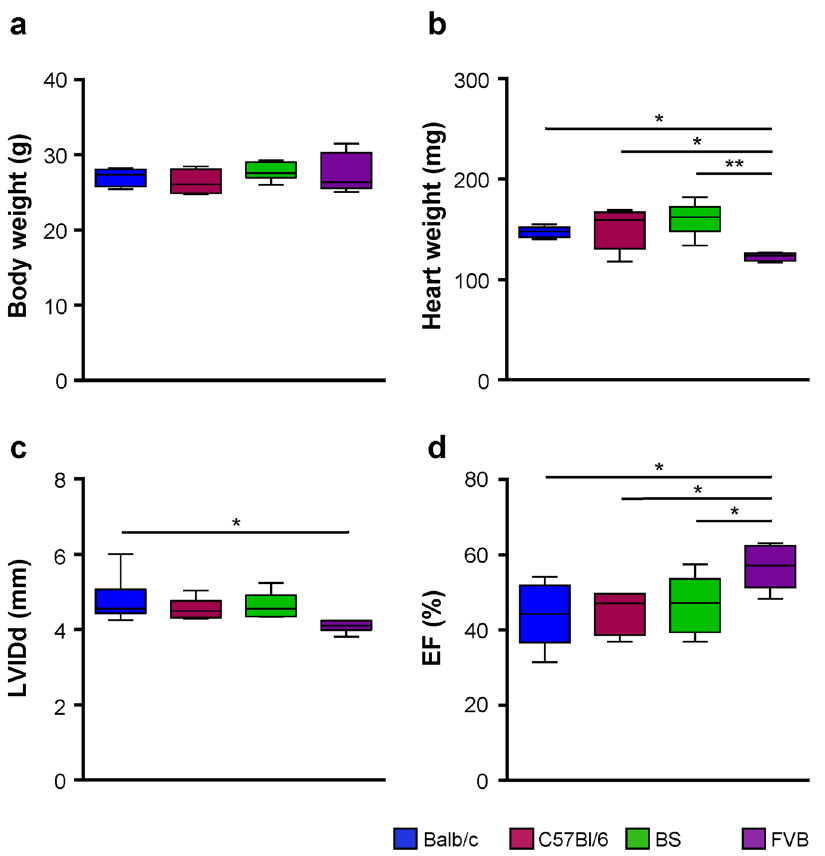
Figure 1. Cardiac geometry and function. ( a ) Body weight and ( b ) heart weight at the time of organ harvesting. ( c ) Diastolic left ventricular inner diameter (LVIDd) and ( d ) ejection fraction (EF). Data are given as median and 5–95 percentile. Balb/c n = 6, C57Bl/6 n = 6, BS n = 6, FVB n = 5. * p < 0.05; ** p < 0.01; *** p < 0.001 (multiple comparisons were calculated by one-way ANOVA followed by Newman-Keuls post-hoc